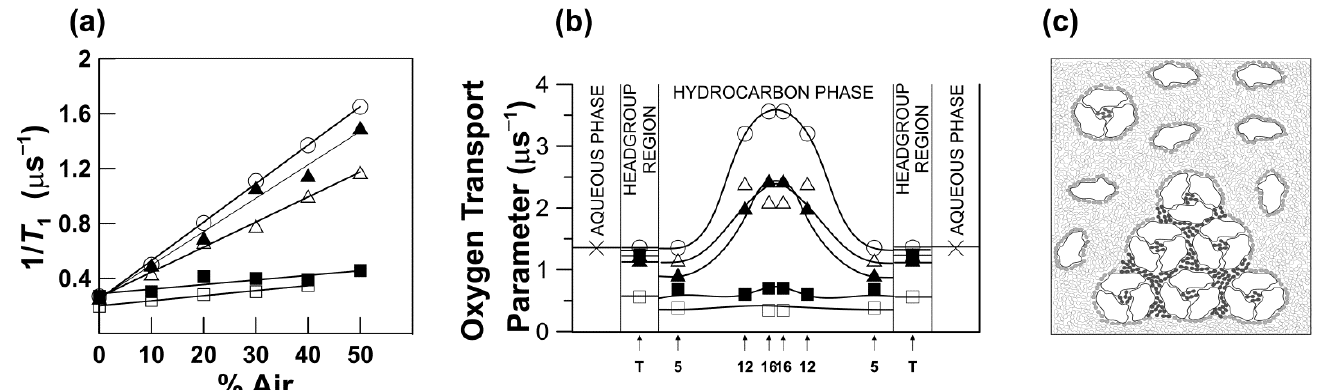
Figure 4. Steps used in the discrimination of membrane domains using the DOT method. ( a ) Spin–lattice relaxation rates of 1-palmitoyl-2-(12-doxylstearoyl)phosphatidylcholine (12-PC) plotted as a percentile of air in the gas mixture equilibrating the membrane suspension at 30 °C. Symbols are for the DMPC bilayer without BR ( ○ ), with BR/DMPC = 1/80 ( ∆ ), with BR/DMPC = 1/40 ( ▲ , ■ ), and for purple membranes isolated from Halobacterium halobium ( □ ). T 1 − 1 values were extrapolated to 100% air and OTP was calculated for each domain. As indicated in Equation (1), the SR signals obtained for the DMPC bilayer without BR, with BR/DMPC = 1/80, and for purple membranes were successfully fitted to single exponentials, giving single values of the OTP for all spin labels (using Equation (1)). SR signals obtained for the DMPC bilayer with BR/DMPC = 1/40 were successfully fitted only to double exponential functions, giving two values of the OTP for each spin label (using Equations (4) and (5)). ( b ) Profiles of the OTP values obtained at 30 °C from different PL spin labels across the DMPC bilayer without BR ( ○ ), with BR/DMPC = 1/80 ( ∆ ), with BR/DMPC = 1/40 ( ▲ , ■ ), and across purple membranes ( □ ). When BR is in the monomeric form, only one bulk-plus-boundary lipid domain is present ( ∆ ). When BR is aggregated, two lipid domains coexist: bulk-plus-boundary domain ( ▲ ) and trapped lipid domain ( ■ ). Arrows indicate approximate locations of nitroxide moieties of n-PCs and n-SASLs used in these investigations. T indicates T-PC. The symbol × indicates OTP in the aqueous phase. ( c ) Schematic drawing of the lateral organization of bacteriorhodopsin and lipid molecules in the reconstituted membrane of BR and DMPC at a BR/lipid ratio of 1/40. Phospholipid molecules are indicated as an open and closed figure-eight-shaped phospholipid cross section. Phospholipids in the bulk domain are open, in the boundary are grey, and in the SLOT domain (trapped lipid domain) are dark. Lipids in the SLOT domain are trapped between trimers and oligomers of trimers of the BR. The schematic shapes of molecules are drawn on the base of the electron microscopy studies [53]. Data for ( a , b ) are reproduced with permission from [28]. Copyright 2022, American Chemical Society.